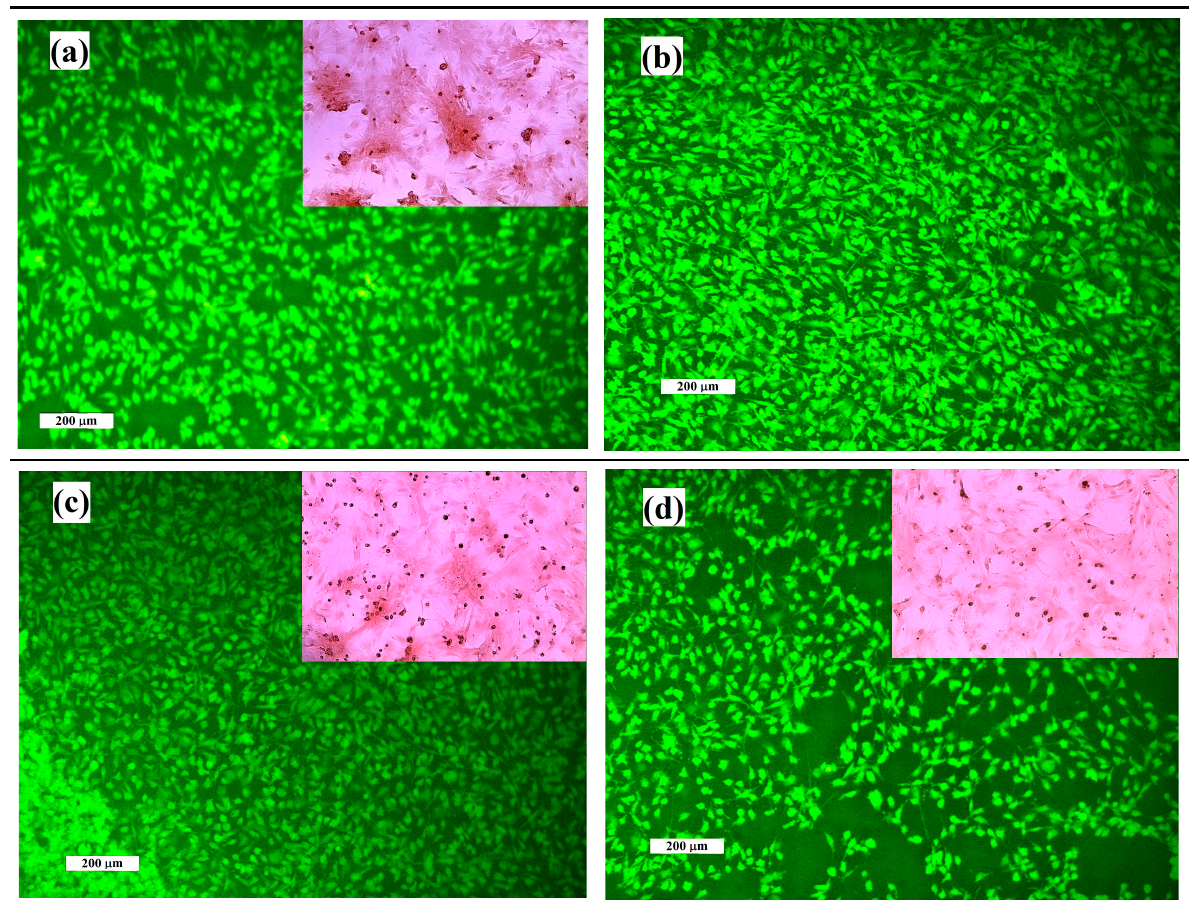
Figure 9. Morphology and distribution of osteoblast cells cultured on TTCPM ( a ), C1MP850 ( b ), C1MP1000 ( c ), and C2MP1000 ( d ) cements for 48 h (live/dead staining) and production of calcium deposits by MSCs cultured in 50% cement extracts for 15 days in details (Alizarin red staining).